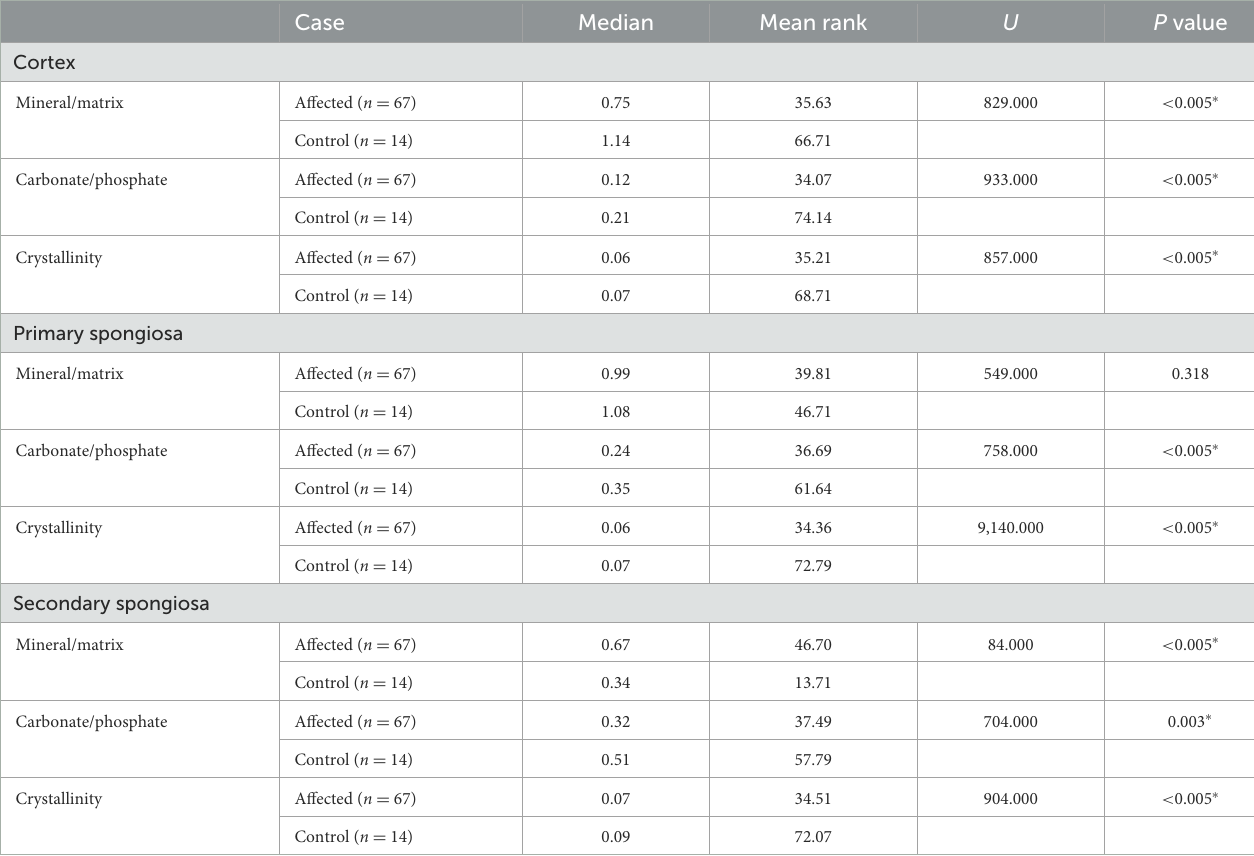
TABLE 1 Mann Whitney U test results of Raman spectra ratios and crystallinity by humeral bone location (cortex, primary, and secondary spongiosa) obtained from affected and control cows. Case